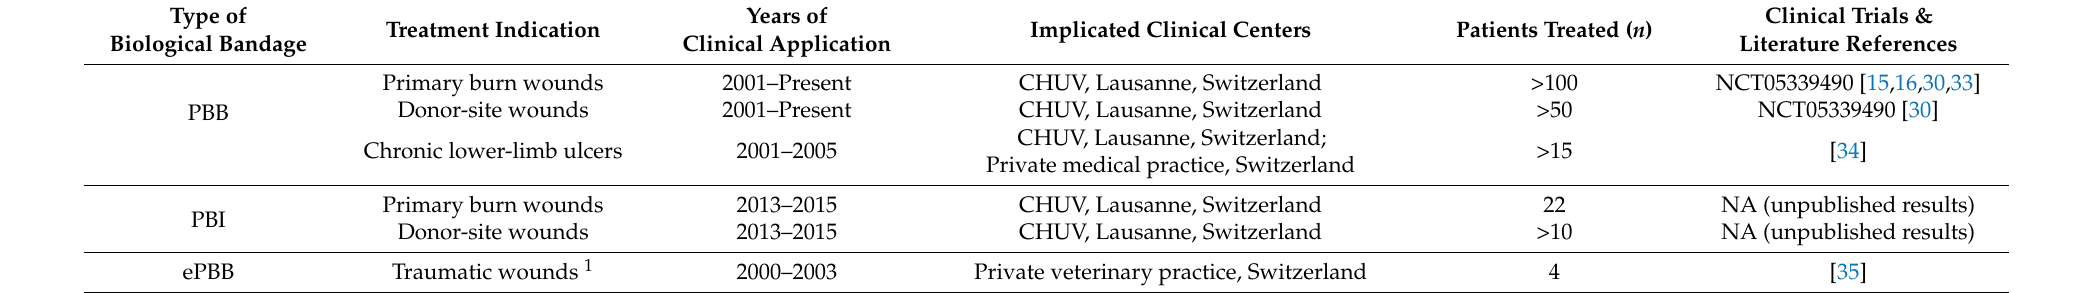
Table 2. Summary of the clinical cytotherapeutic applications of cultured allogeneic dermal progenitor fibroblasts (i.e., viable cells at the time of application) in a specific pharmaceutical form (i.e., biological bandages) and in various therapeutic indications. In parallel to the clinical work performed in Switzerland, further investigative use of dermal progenitor fibroblasts under the framework of the Swiss progenitor cell transplantation program has been carried out in Asia for skin donor-site wounds (i.e., NCT02737748 trial, registered in 2016) and diabetic foot ulcers (i.e., NCT03624023 trial, registered in 2018). It is important to note that since 2009, following regulatory updates and transition to GMP processing, all human patients have been treated with viable dermal progenitor fibroblasts from the bandage; PBI, progenitor biological bandage yielding γ -irradiated